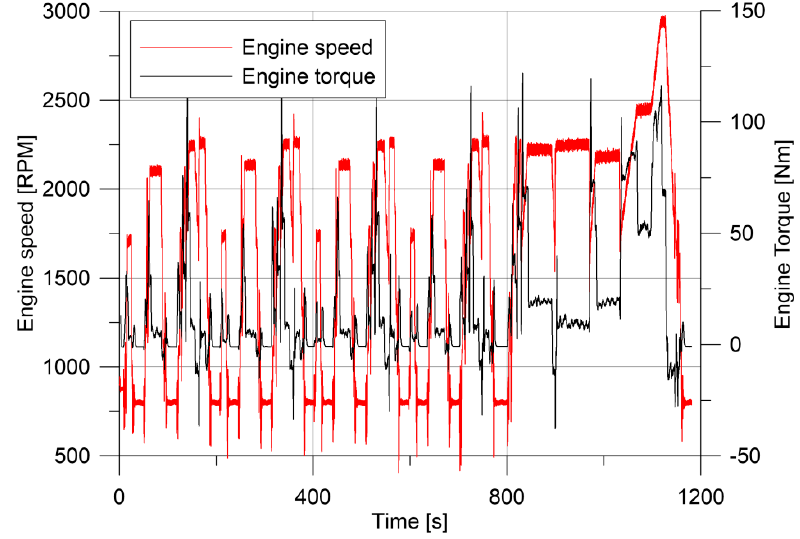
Figure 2. Engine speed and torque sequence in test bench NEDC reproduction.